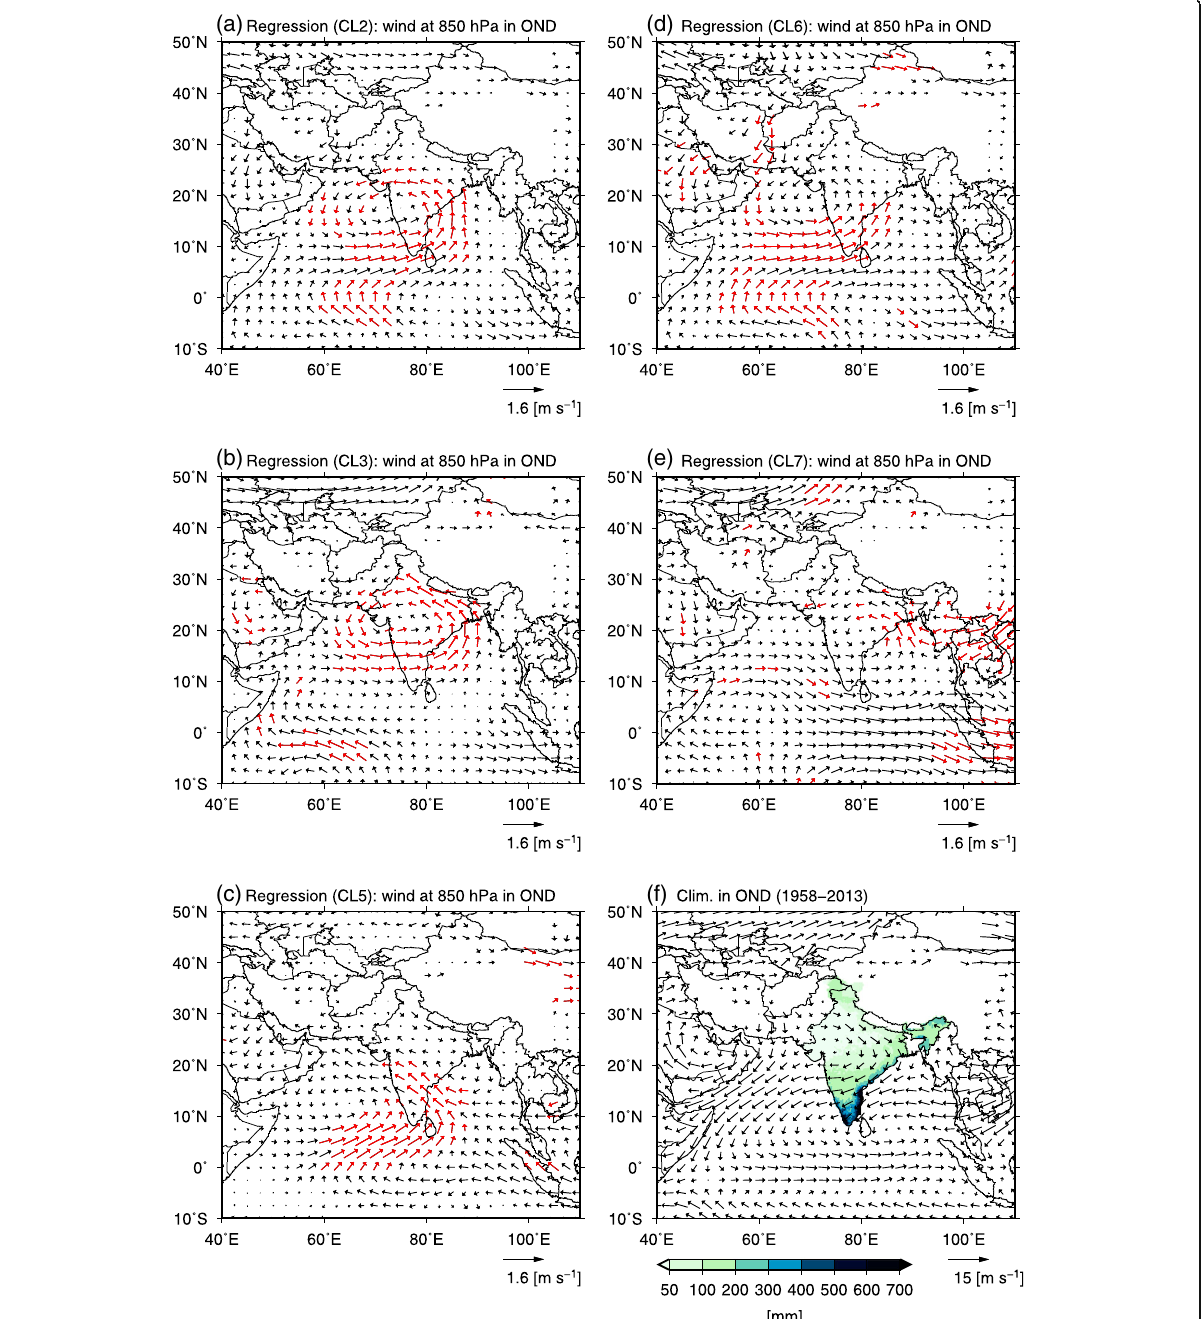
Fig. 9 Same as Fig. 7 but for the post-monsoon season (OND) The regression coefficient (objective variable is precipitation) between interannual variation of rainfall and the wind field at 850 hPa (m s − 1 ) (vector) for each cluster ( a ) – ( e ), and the distribution of the climatological values (averaged for 1958 – 2013) of seasonal precipitation and wind vectors at 850 hPa, as in Fig. 6c ( f